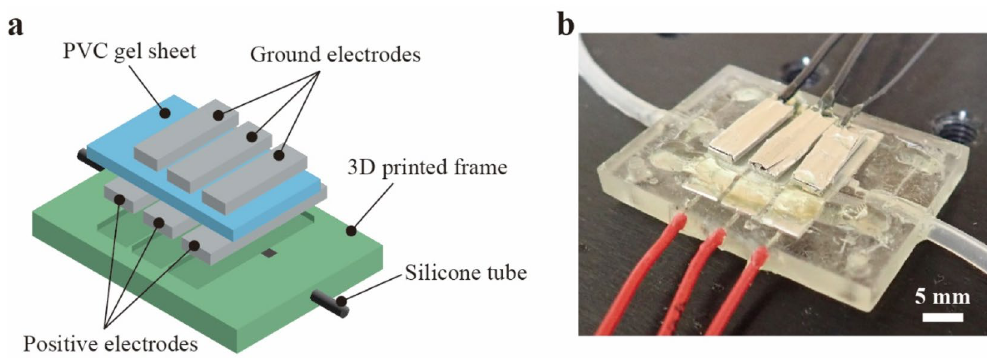
Figure 1. ( a ) Structure of the polyvinyl chloride (PVC) gel pump. ( b ) PVC gel pump developed in this study.